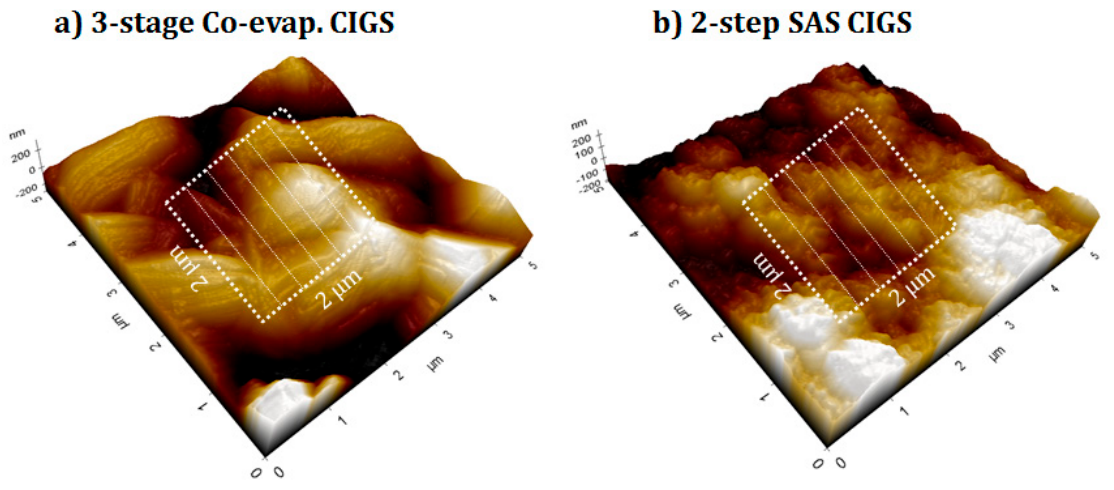
Figure 4. 3D AFM images of the ( a ) three-stage co-evaporated CIGS and ( b ) two-step SAS CIGS.